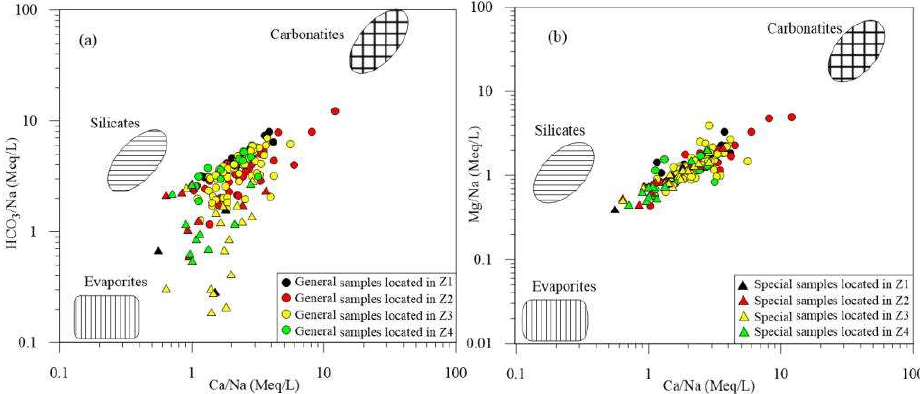
Figure 5. Bivariate diagrams of ( a ) (HCO 3 /Na) versus (Ca/Na), ( b ) (Mg/Na) versus